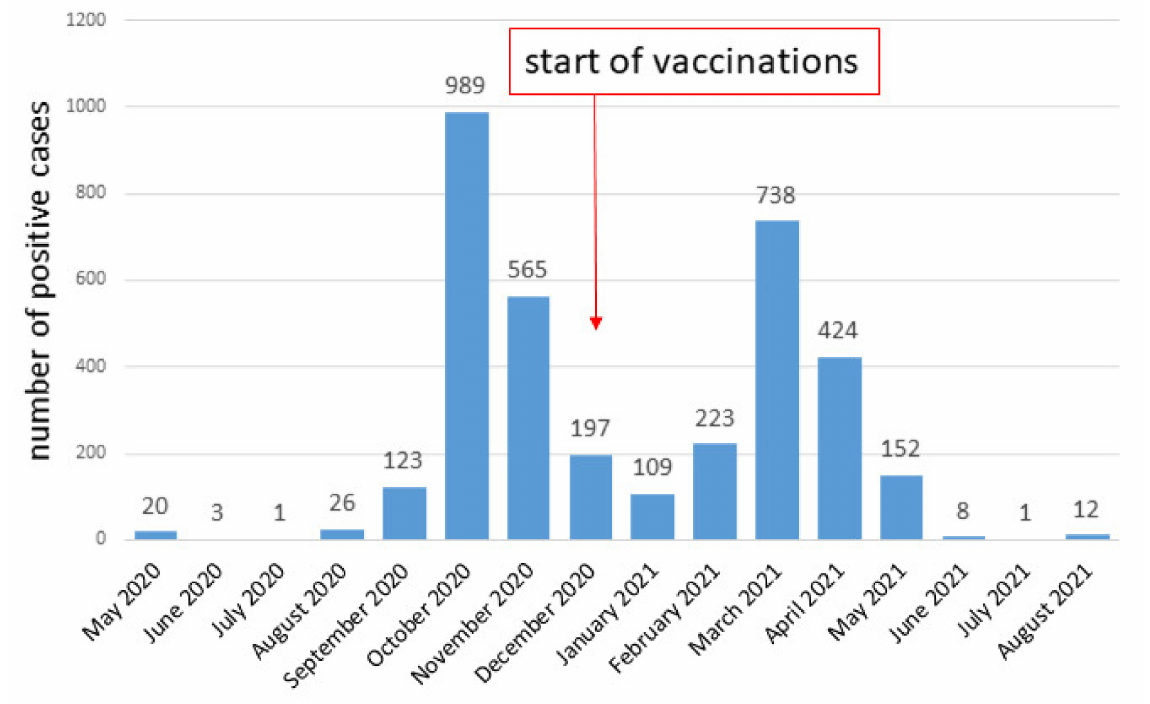
Figure 2. Monthly SARS-CoV-2 infection cases in the examined population.